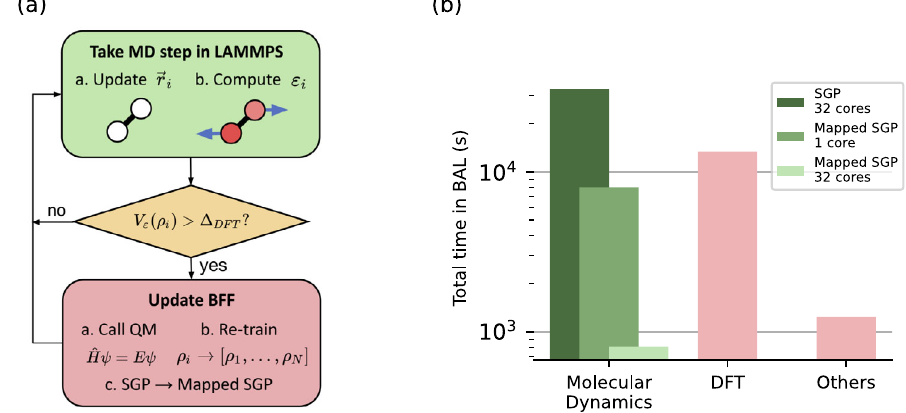
Fig. 1 Work fl ow and performance. a Bayesian active learning (BAL) work fl ow with LAMMPS. It closely follows our previous work 19 , with the key addition that the SGP uncertainties are now mapped and therefore much cheaper, and the MD part of the training can be done within LAMMPS. b Time pro fi ling of the BAL work fl ow with a system of 72 atoms and 100,000 MD time steps. The SGP BAL work fl ow collected 14 frames with 72 atoms each, with 10 representative sparse environments selected per frame. The MD is greatly accelerated using mapped forces and uncertainty compared to sparse GP. “ Others ” includes time consumed outside of MD and DFT, e.g. adding training data to SGP and optimizing